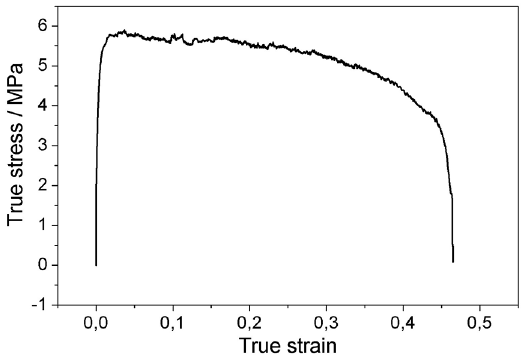
Figure 7. True stress vs. true strain curve of the AA5083-O performed at a constant strain rate of 5.0x10 -5 s -1 and temperature of 570ºC